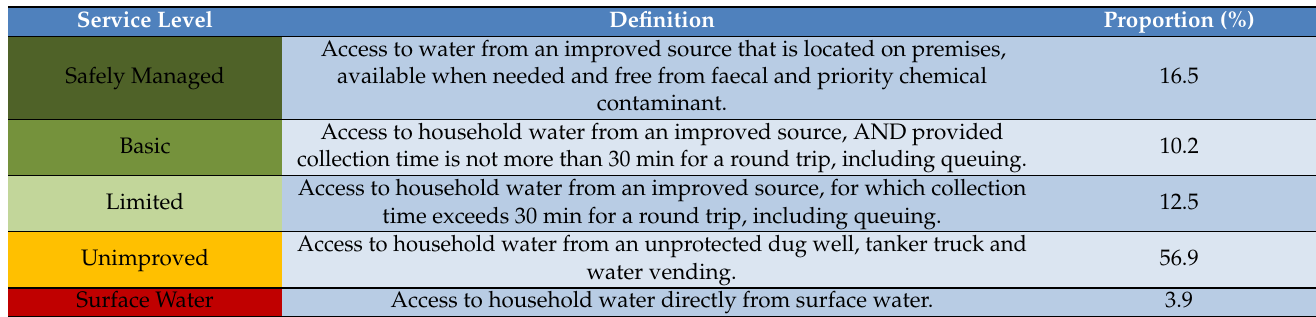
Table 6. The household water access service